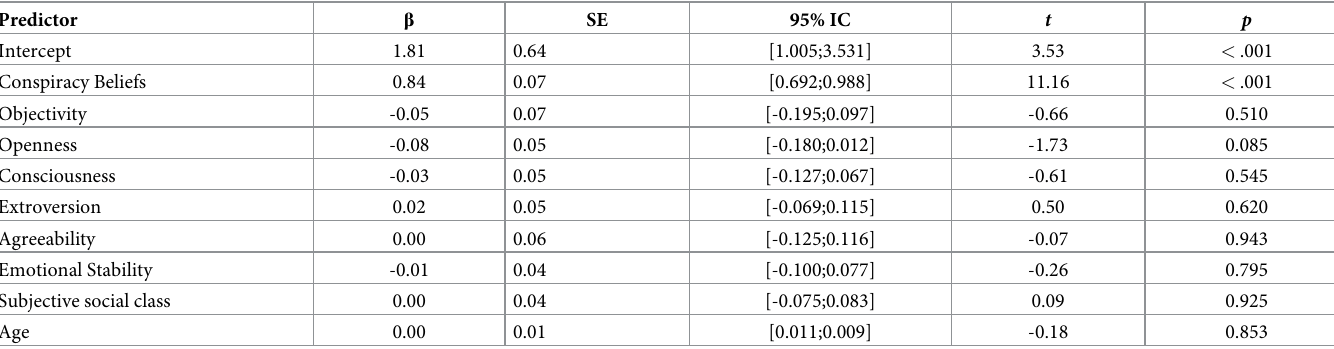
Table 4. Regression analysis to predict credibility towards science (Study